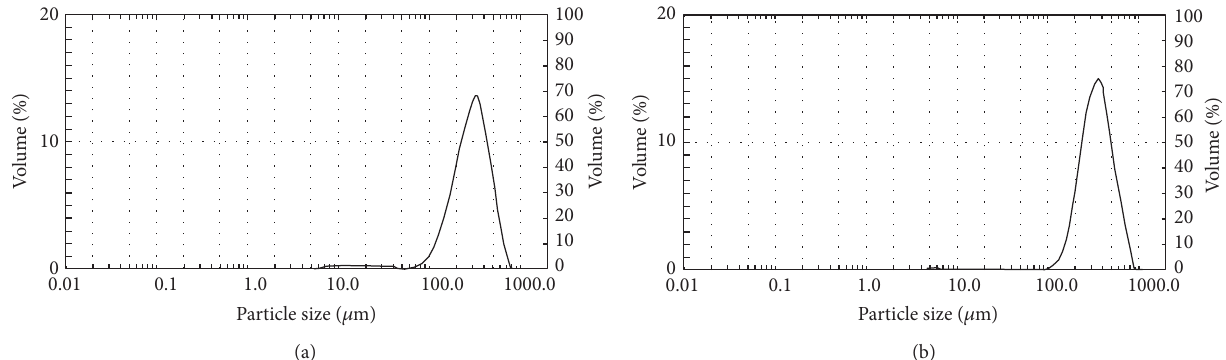
Figure 2: Size distribution of (a) alginate/gelatin BBH loaded microspheres and (b) chitosan-coated alginate/gelatin BBH loaded micros- pheres.